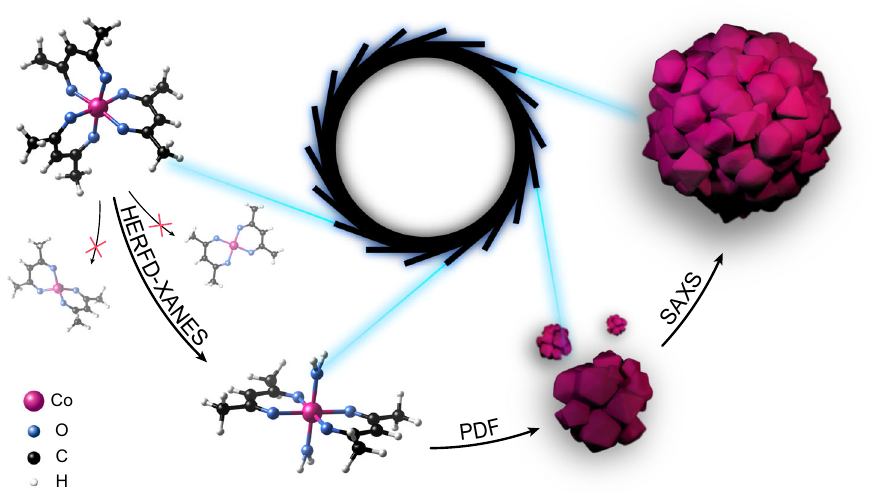
Fig. 7 Overview of the emergence of nano-assemblies of CoO in benzyl alcohol. Complementary X-ray spectroscopic and scattering methods enable the bridging of the studies of the reaction mechanism from molecular- to macro- length scales. We combined high energy-resolution fl uorescence-detected X- ray absorption near edge structure (HERFD-XANES), pair distribution function (PDF) analysis and small-angle X-ray scattering (SAXS) to follow the emergence of CoO nanoassemblies in